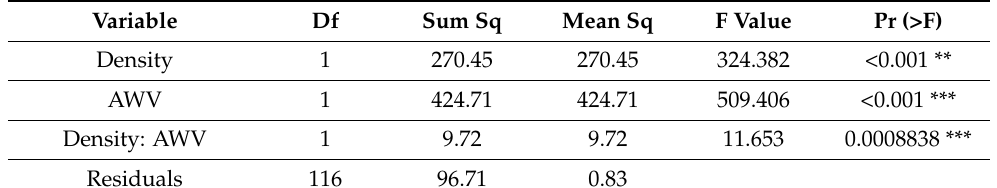
Table 2. The results of the ANOVA test.